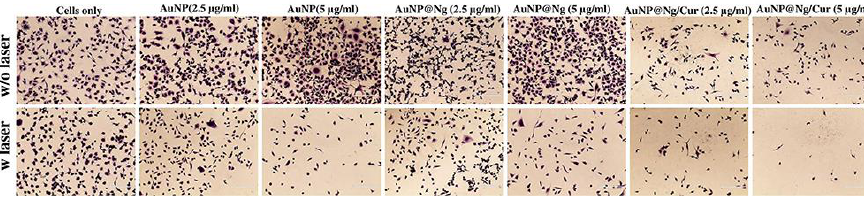
Figure 3. Nanogel induced cell death after irradiation (modified from [59]).